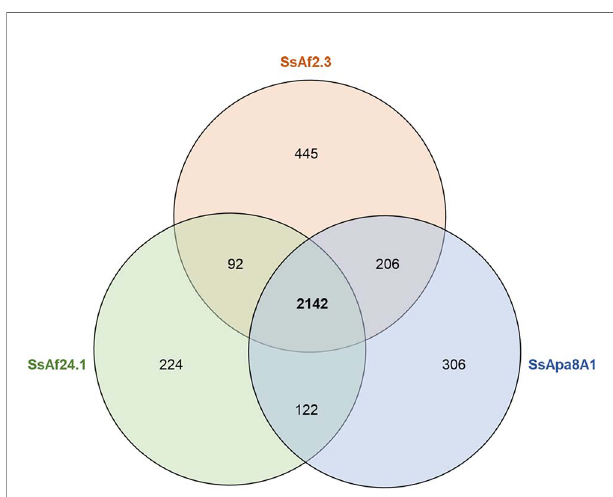
FIGURE 3 | Venn diagram comparing the gene inventories of the three culturable S. symbiotica genomes computed by EDGAR (Blom et al., 2016) based on reciprocal best BLAST hits of the coding sequences predicted by PGAP (Tatusova et al.,